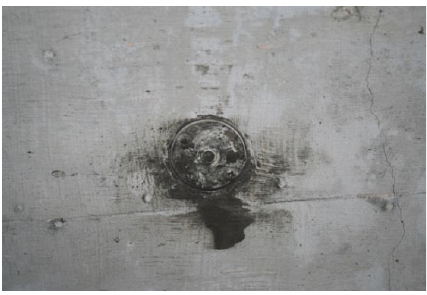
Figure 4: Piezoelectric pressure